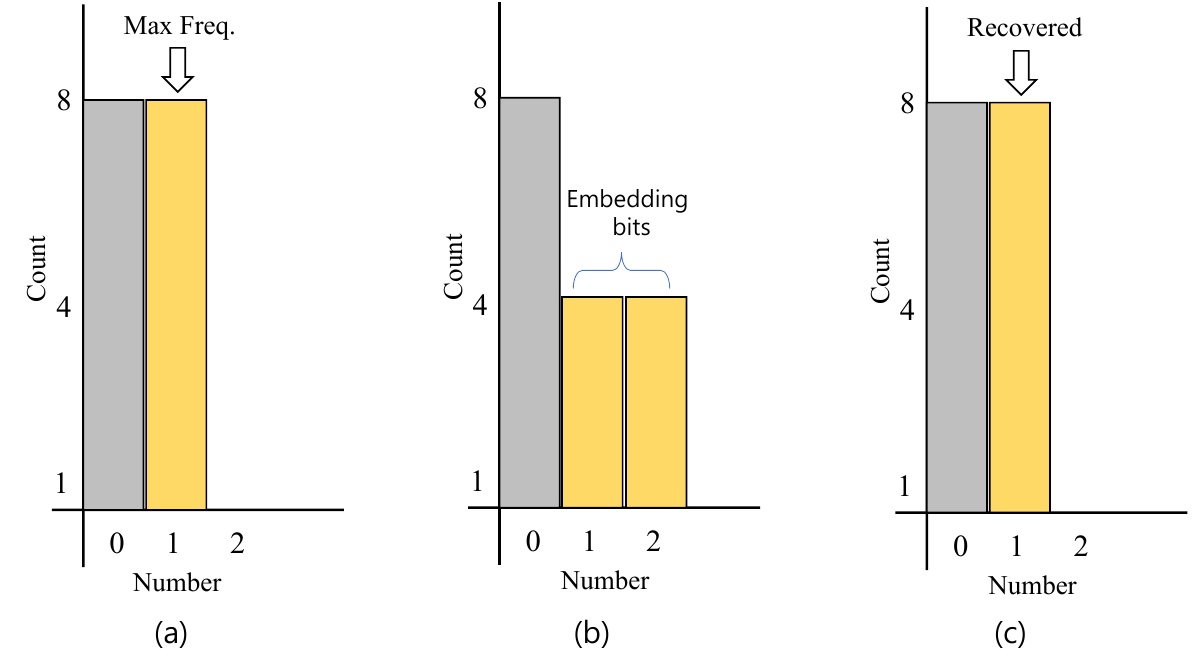
Figure 6. Embedding procedure using histogram shift based on 4 × 4 BM: ( a ) histogram generation of a BM (4 × 4), ( b ) histogram after embedding bits, and ( c ) extraction of hidden bits and reconstructed